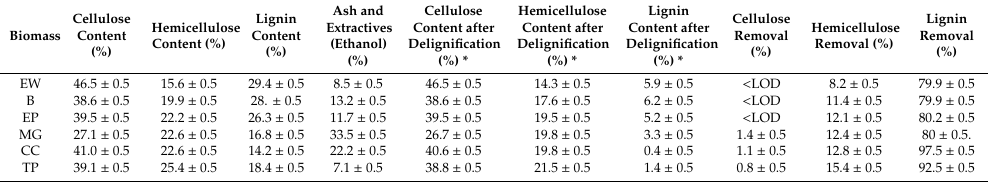
Table 1. Content of cellulose, hemicellulose and lignin in lignocellulosic biomasses of energetic willow wood (EW), beech wood (B), energetic poplar wood (EP), meadow grass (MG), corn cobs (CC) and triticale paleas (TP) before and after the MEA